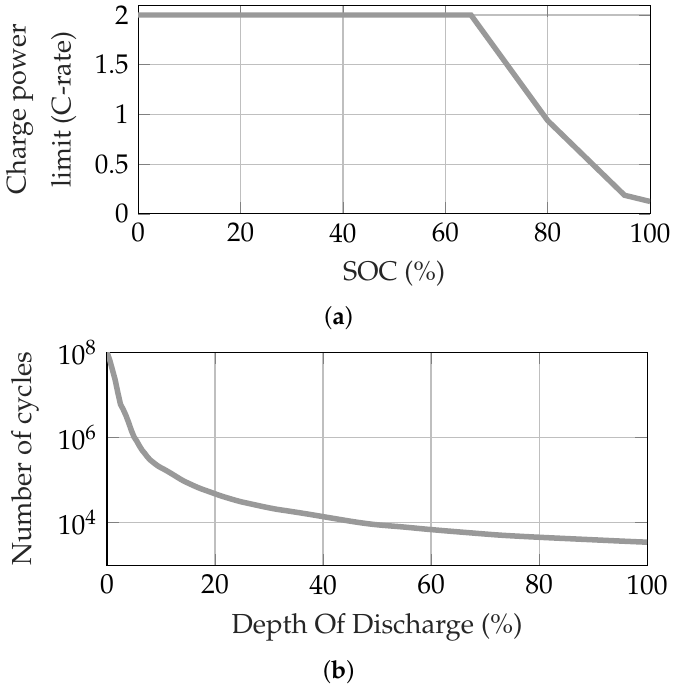
Figure 10. Battery characteristics. ( a ) Charging power limit. ( b ) Relation between number of cycles and depth of discharge (DoD) of the battery. Used in order to estimate how much of the battery’s life that is consumed.